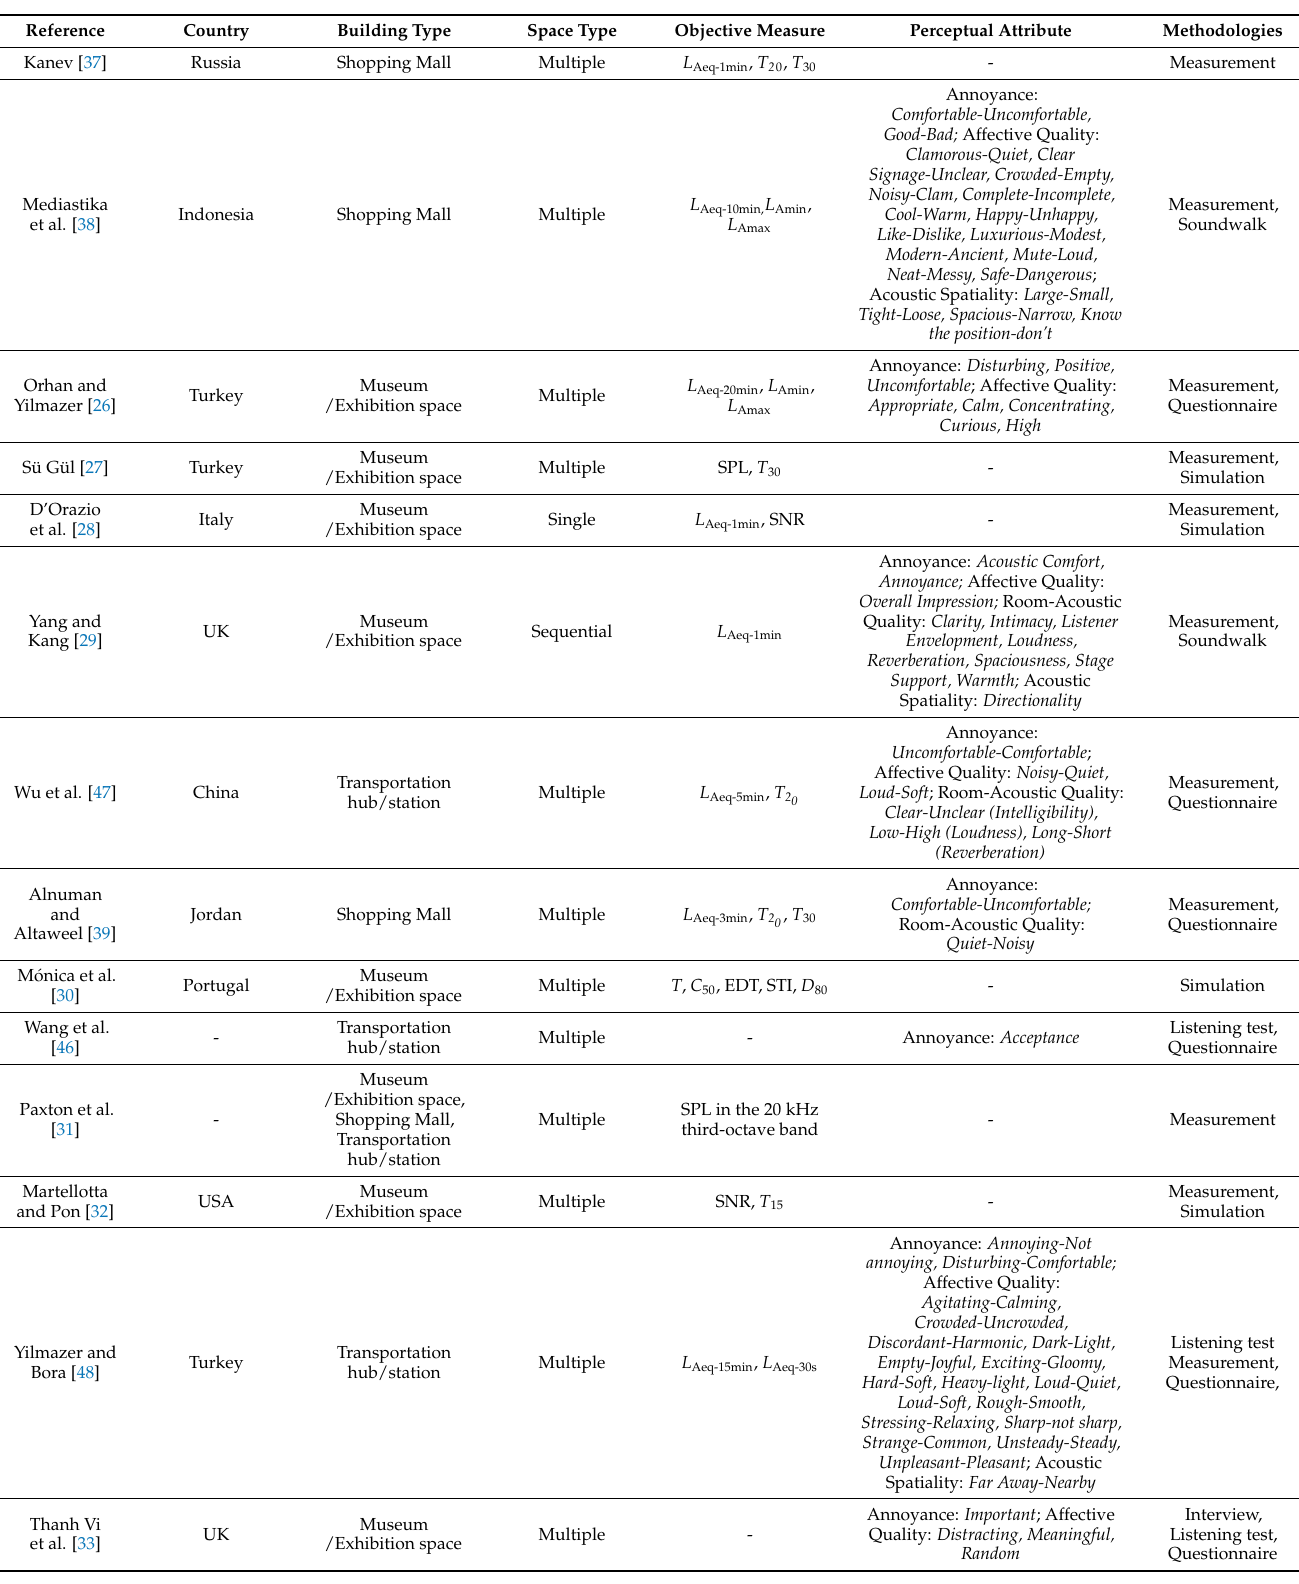
Table 1. List of studies included in the systematic review in chronological order of publication. The country, building type, space type, objective measure, perceptual attribute, and methodologies were reported. The studies often included several experimental conditions and sound levels. Therefore, for more specific information, it is possible to refer to the original